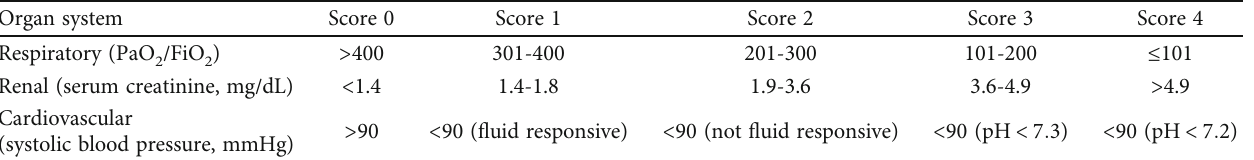
Table 1: Modi fi ed Marshall scoring system for organ dysfunction (a score of 2 or more in any system de fi nes the presence of organ failure). Organ